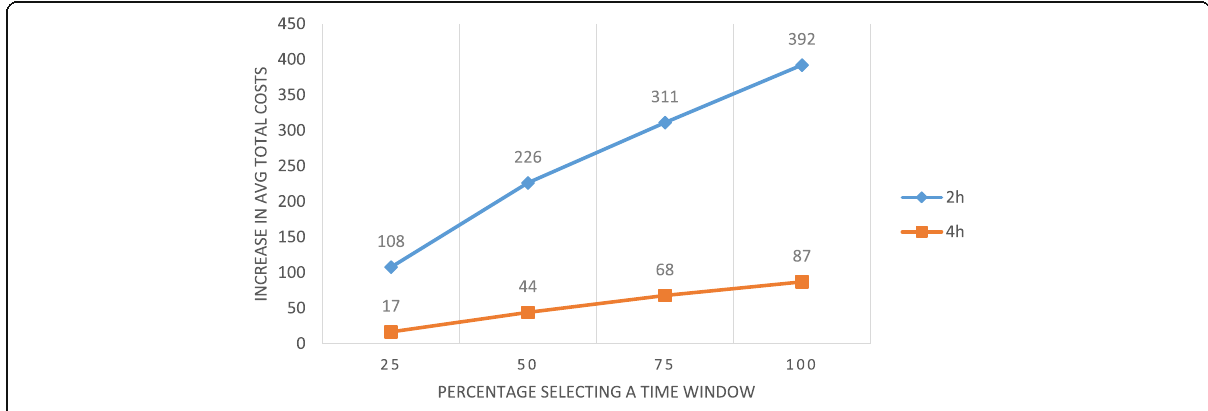
Fig. 3 Interaction plot of F2 X F3 interaction for clustered